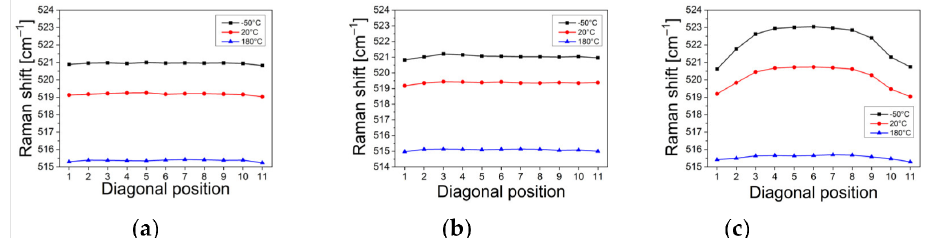
Figure 9. Raman shift distribution along the diagonal recorded at − 50 (black points and lines), 20 (red points and lines) and 180 ◦ C (blue points and lines), on ( a ) Si_Unmounted chip, ( b ) A_AuSn_p sample and ( c ) A_AuSn sample (C). Position i refers to the position [i,i] of Figure 4b.